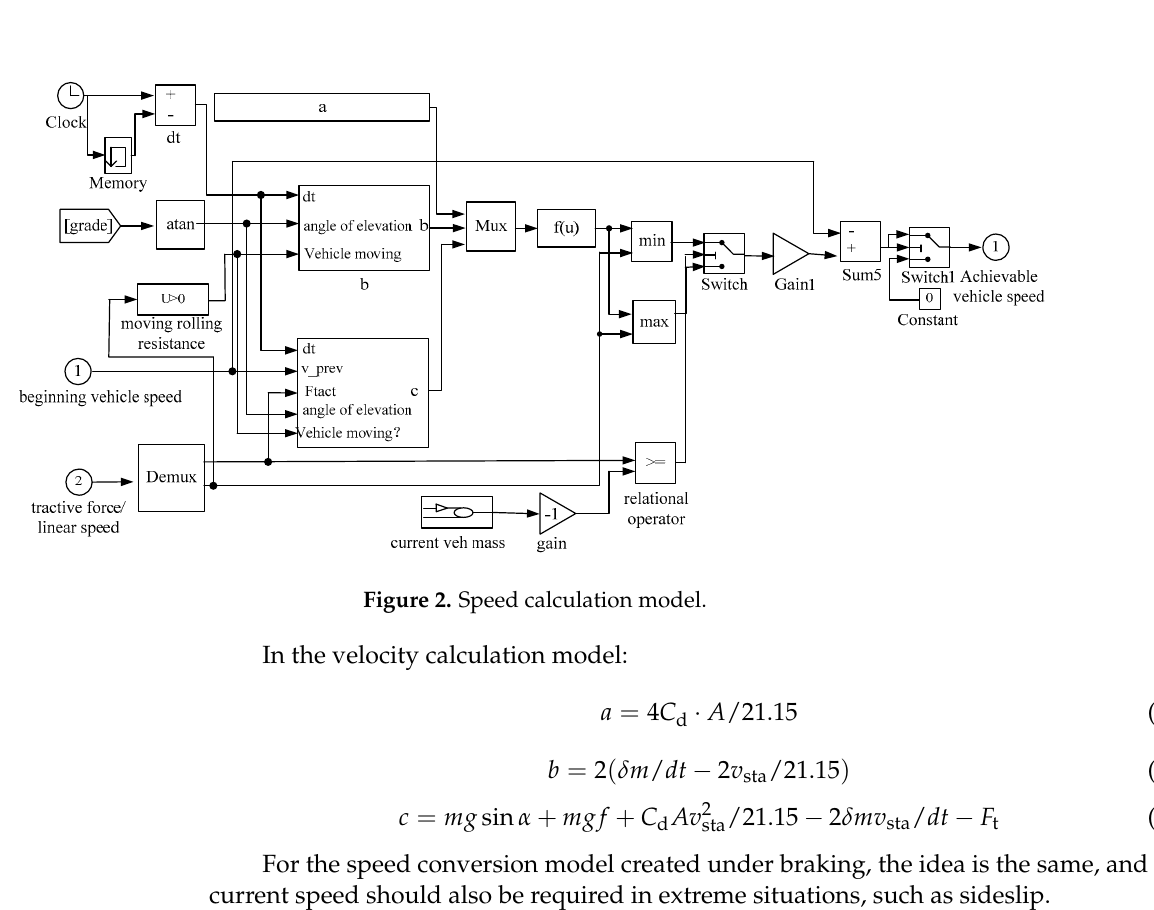
Figure 1. Vehicle resistance calculation model.